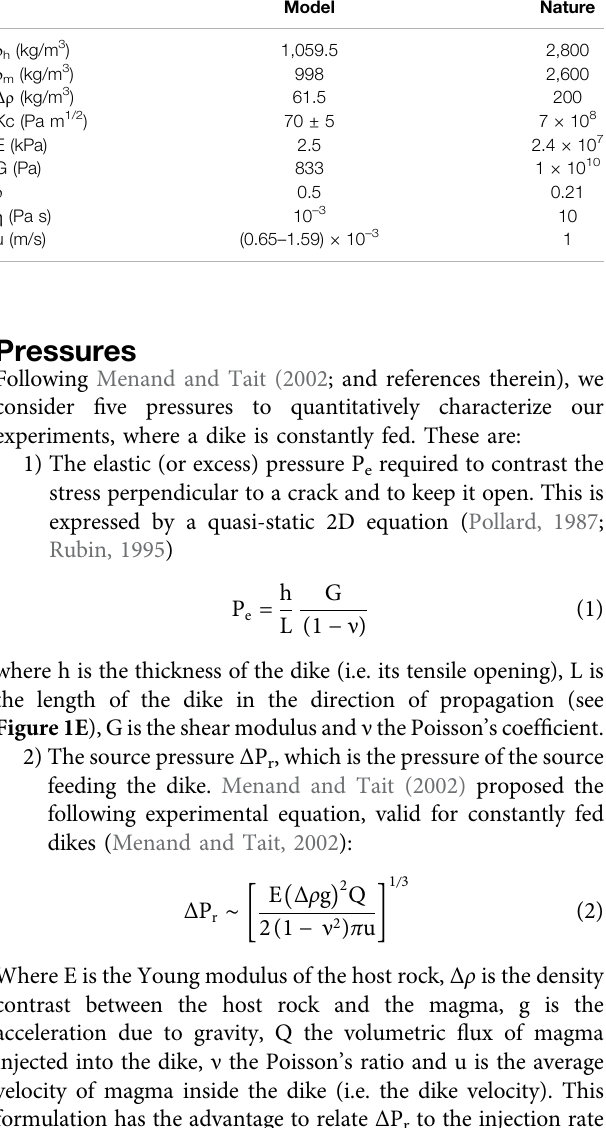
TABLE1| Mechanicalpropertiesofanaloguematerialsandnature. ρ h (cid:1) densityof TABLE 2 | Injection rate, overpressures and scaling. the host rock (gelatin in the models); ρ m density of the magma (water in the Q (m 3 /s) (x10 – 6 ) models). Δρ is the density contrast. ν is the Poisson ’ s ratio of the gelatin (model; from Kavanagh et al., 2013) and the host rock (nature; Heap et al., 2009). K c isthe fracture toughness: for the gelatin, K c has been calculated from the Young (cid:7)(cid:7) √ modulus (E), using the equation (Kavanagh et al., 2013): K c (cid:1) ( 1 . 4 ± 0 . 1 ) E (E (cid:1) 2.5 kPa; Sili et al., 2019). Values of K c in nature are from Gudmundsson, (2009);Rivaltaetal.,2015.Gistheshearmodulusofthehostrock(valuesofE and G in nature are from Heap et al., 2009). η is the viscosity of the water (model) and magma (nature); u is the velocity of the dike (from Traversa et al., 2010 in nature, while for the models it has been directly calculated from the experiments; see Supplementary Figure S1 ). Table 2 . Q is the injection rate used in each experiment. Δ P r , P b , P e are the pressures de fi ned by Eq. 1 – 3 , calculated in the models at a length L (cid:1) L b . P 1 * is the pressure Model